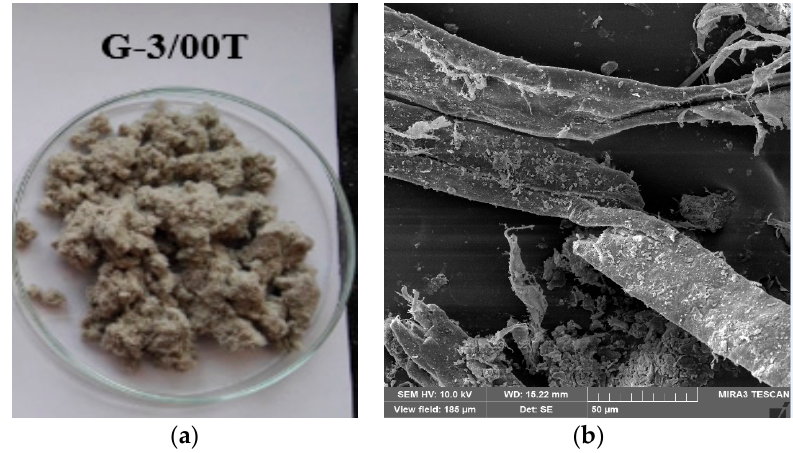
Figure 1. Recycled waste paper fibers G-3/00T Greencel: ( a ) macro view; ( b ) SEM image at 1500 times magnification. Table 1. Properties of recycled waste paper cellulosic fiber Greencel.